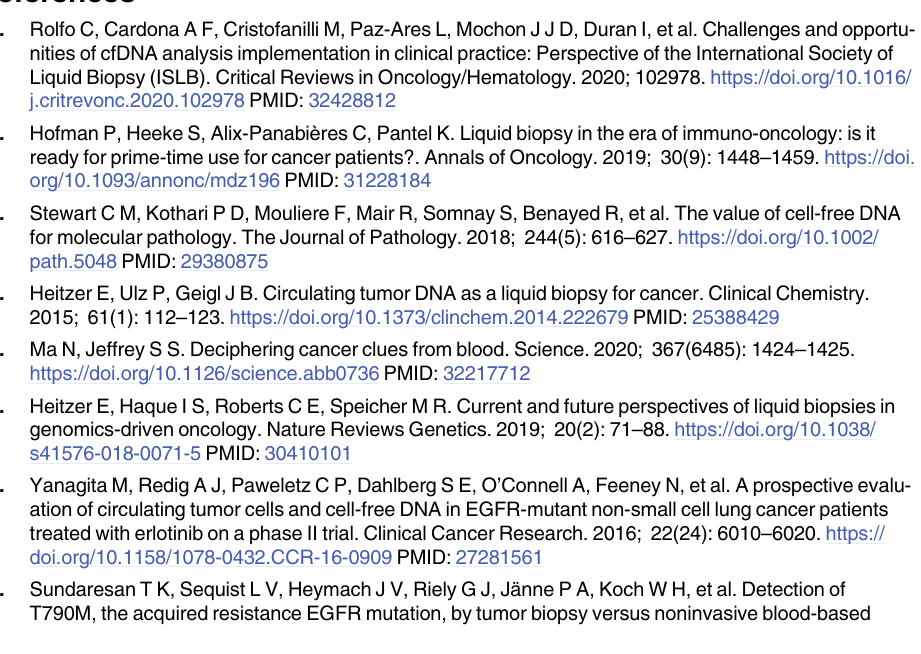
S1 Table. CcfDNA yields of single experiments. Yields were determined by using a Qubit 2.0 Fluorometer and Qubit ™ 1x dsDNA HS Assay-Kit.